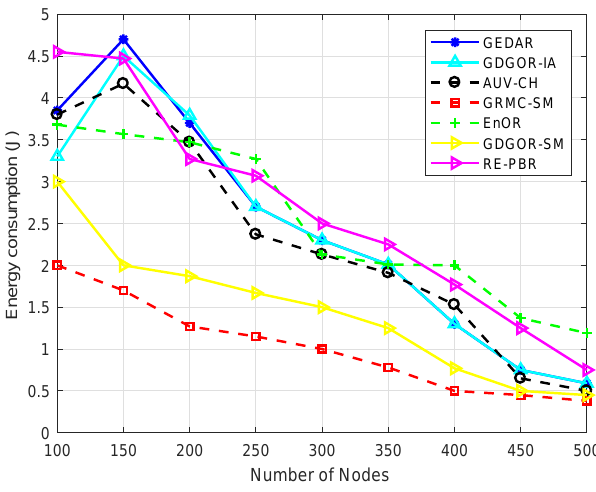
Figure 11. Energy consumption comparative